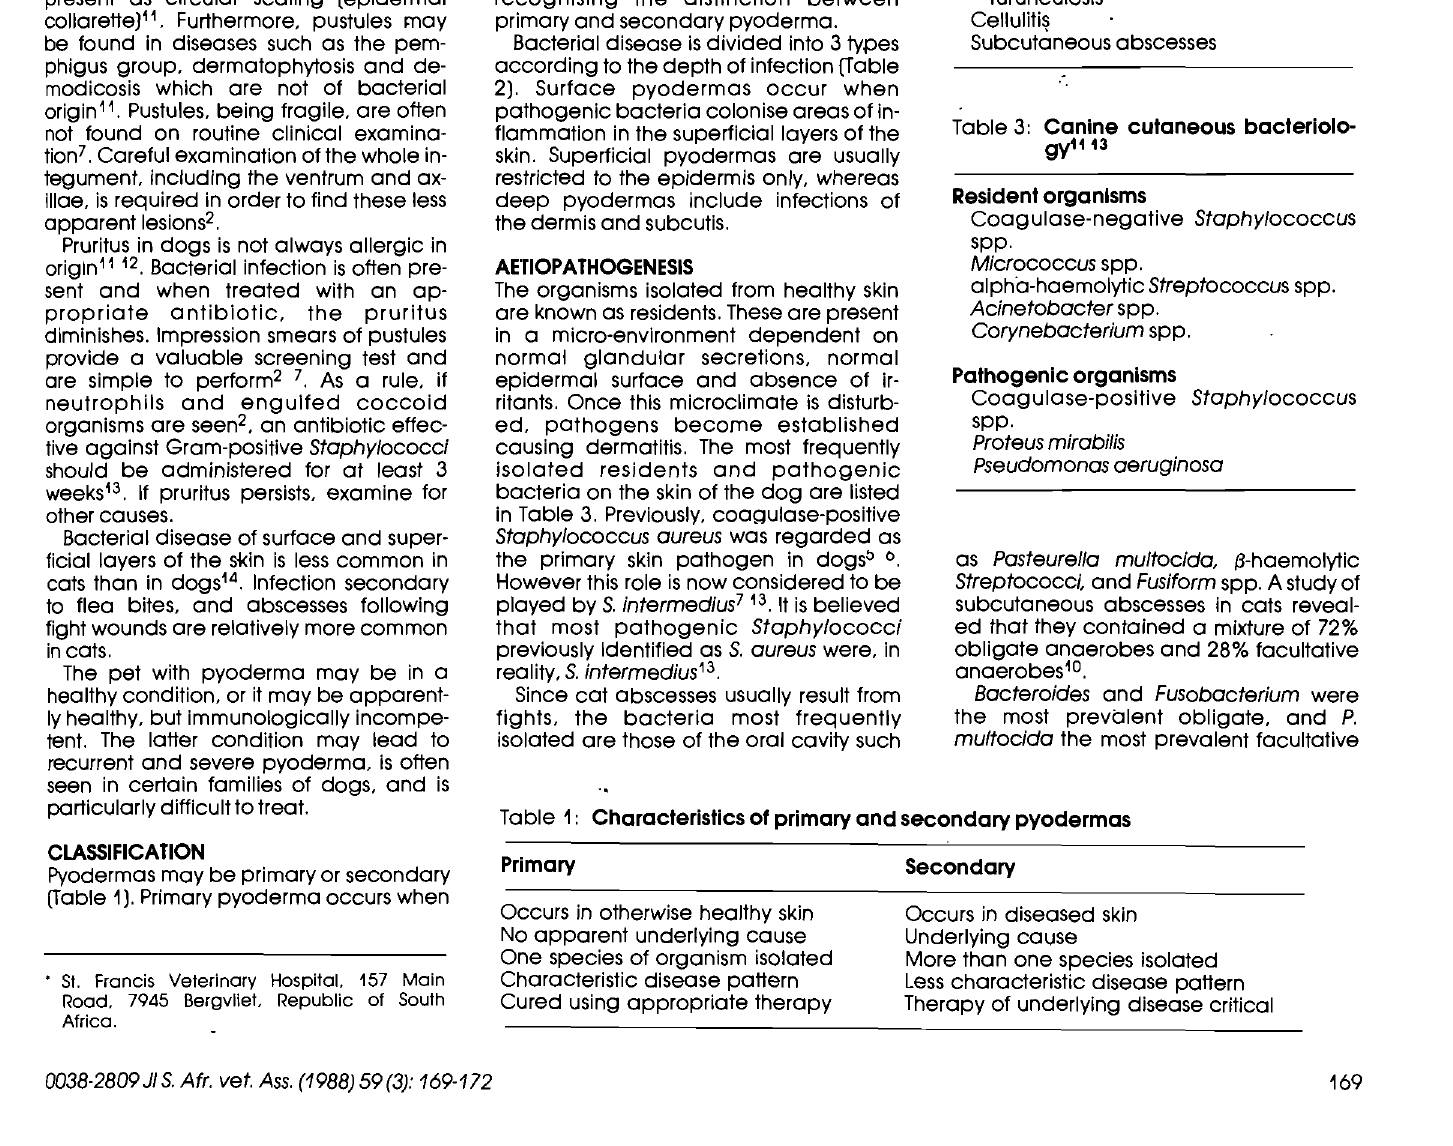
CLASSIFICATION Pyodermas may be primary or secondary (Table 1). Primary pyoderma occurs